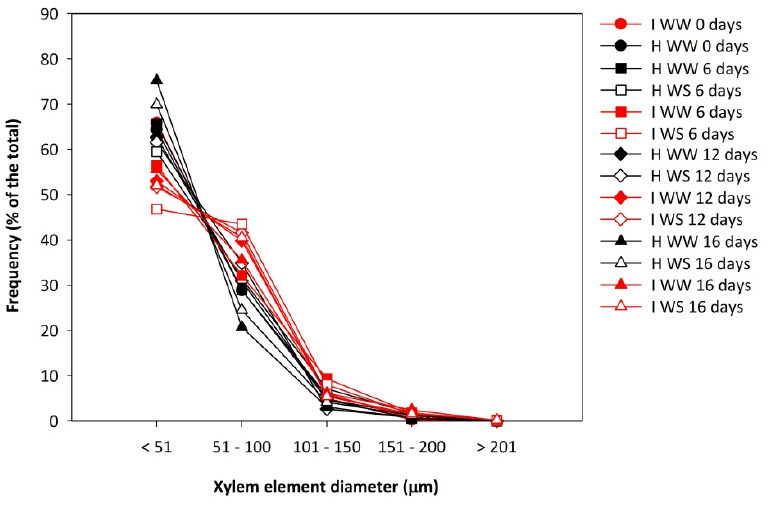
Figure 5. Relative frequency of occluded xylem elements of different diameter class of shoot sections of potted own–rooted grapevines of cv. Schioppettino before the water stress and during the water stress, and after the recovery. Plants are separated regarding to plant health, water status and days from water stress start: well–watered healthy (H WW), well–watered GFLV–infected (I